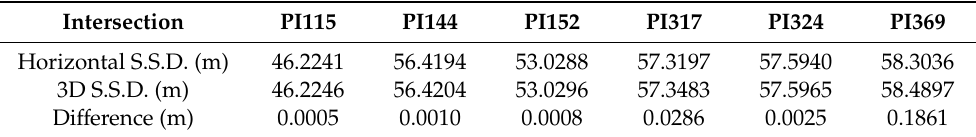
Table 2. Calculation results of S.S.D. at each intersection